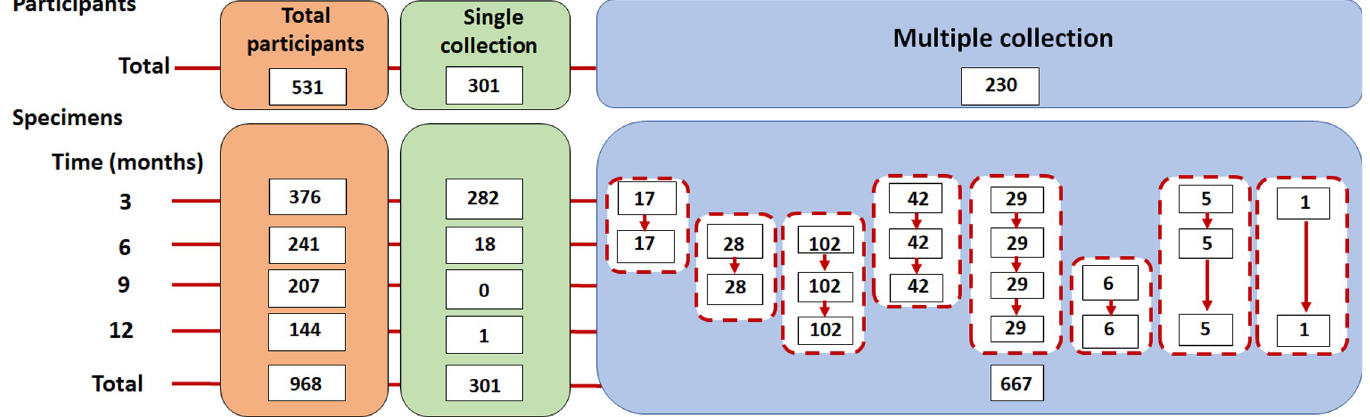
Fig 1. Flow diagram of participant recruitment and specimen collection in this study. A total of 531 participants were enrolled.